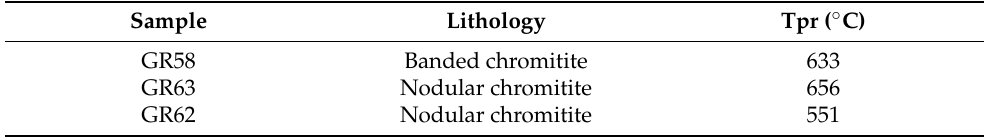
Table 7. Primary temperatures at Nea Roda, calculated using average Mg# at the core of the minerals.